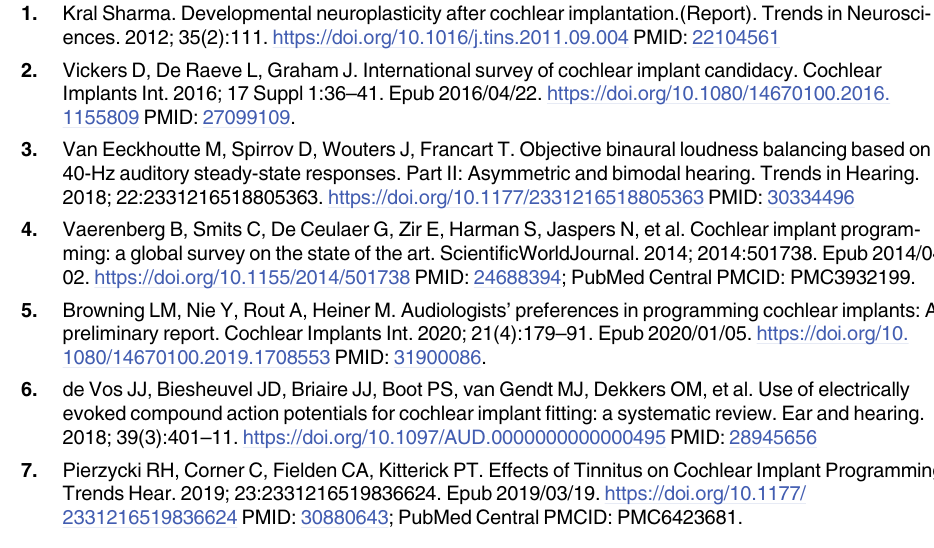
S1 Table. Raw data on participants demographics and the speech token present (1) or absent (0) before and after CAEP measurement and CI optimisation. S2 Table. Means and standard deviation for the speech perception scores for the subjec- tively optimised group, subjectively non-optimised group and before/after optimisation for the objectively optimised